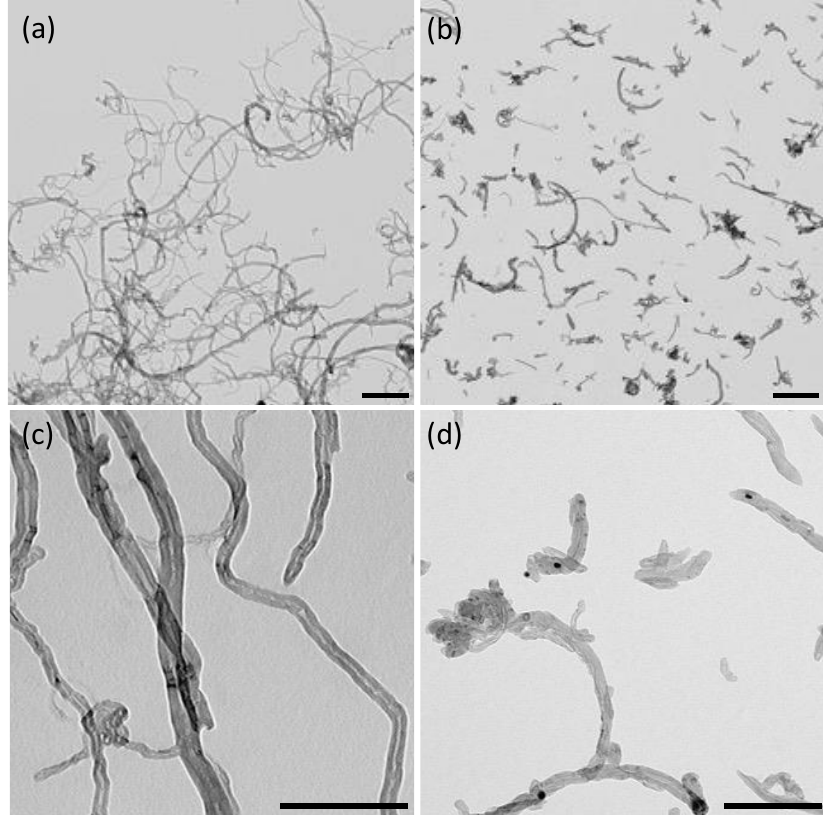
Figure 1. TEM images of CNTs long ( a , c ) and CNTs short ( b , d ). The scale bar is 500 nm in ( a , b ) and 200 nm in ( c , d ).